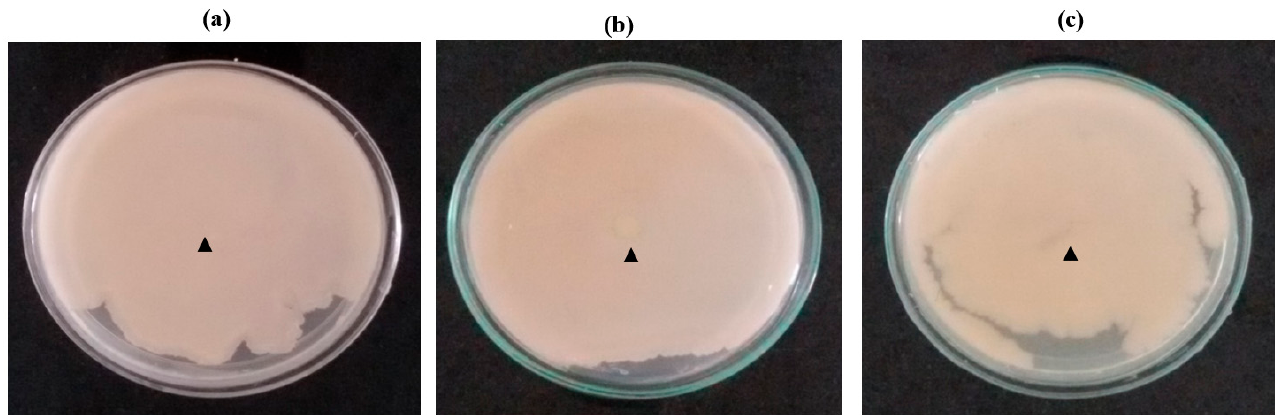
Figure 1. Point Inoculation at 16 h: ( a ) C. albicans M-207; ( b ) E. coli ATCC 39936; ( c ) C. albicans M-207 + E. coli ATCC 39936. The arrowhead indicate the point of inoculation of the culture.